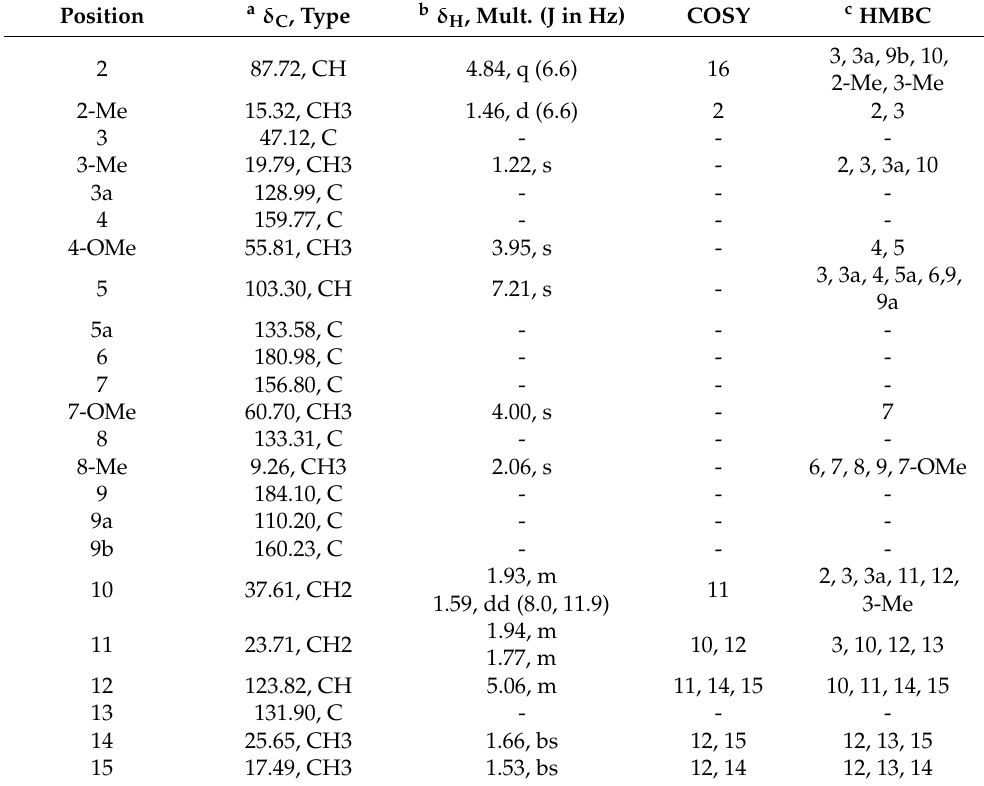
a 125 MHz for 13 C-NMR. b 500 MHz for 1 H-NMR. c HMBC correlations from protons to the indi- cated carbons.